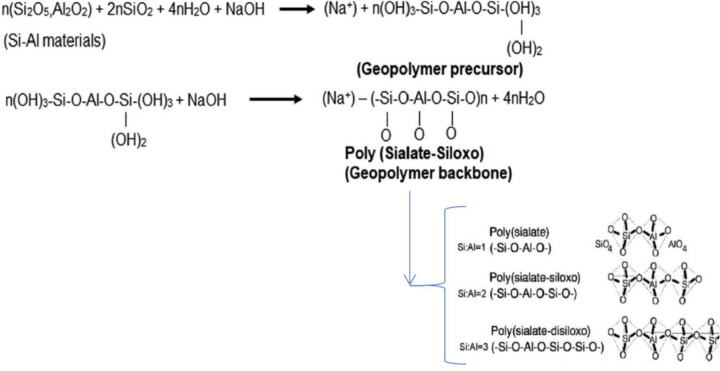
Schematic representation of geopolymerization [37, 38].